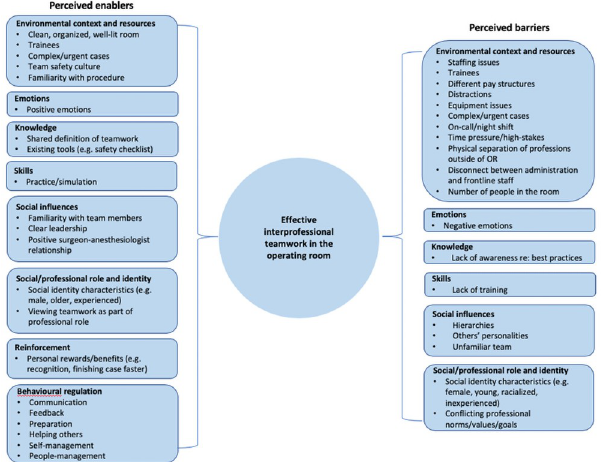
Fig 1. Barriers and enablers to interprofessional teamwork in the OR reported by participants (n = 66).